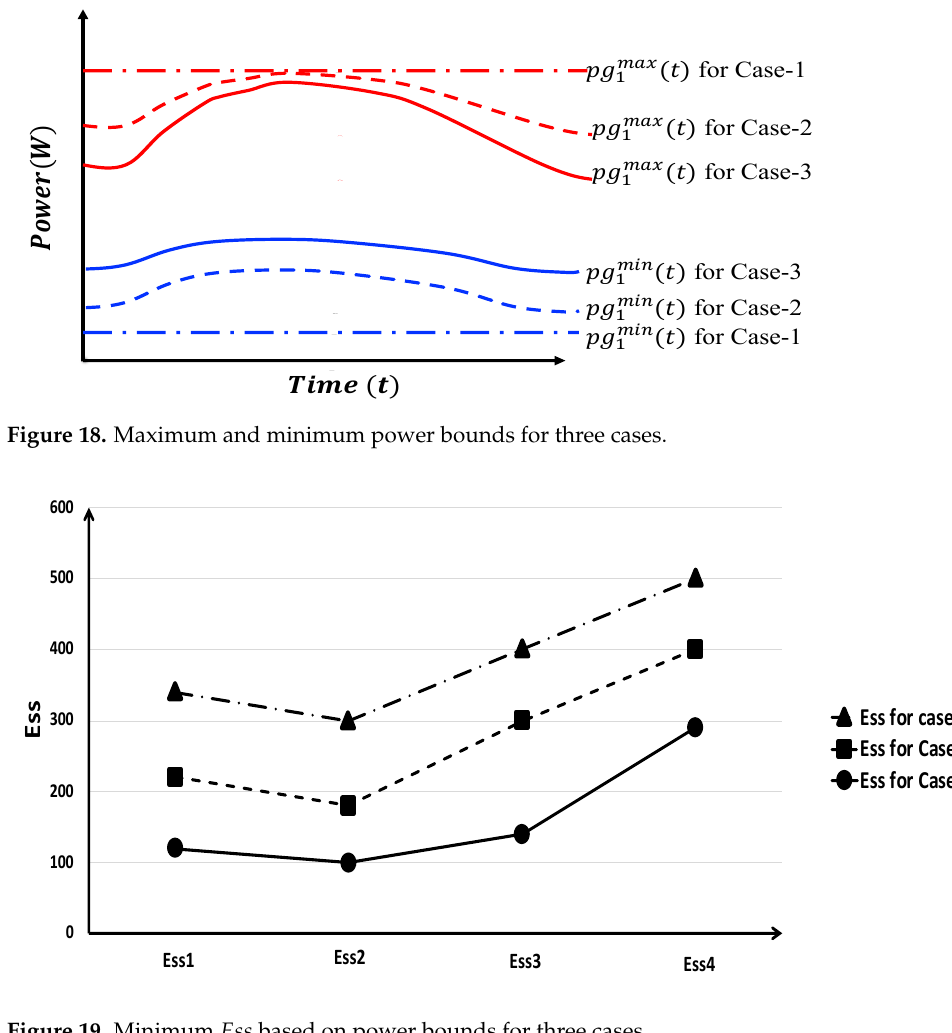
Figure 19. Minimum Ess based on power bounds for three